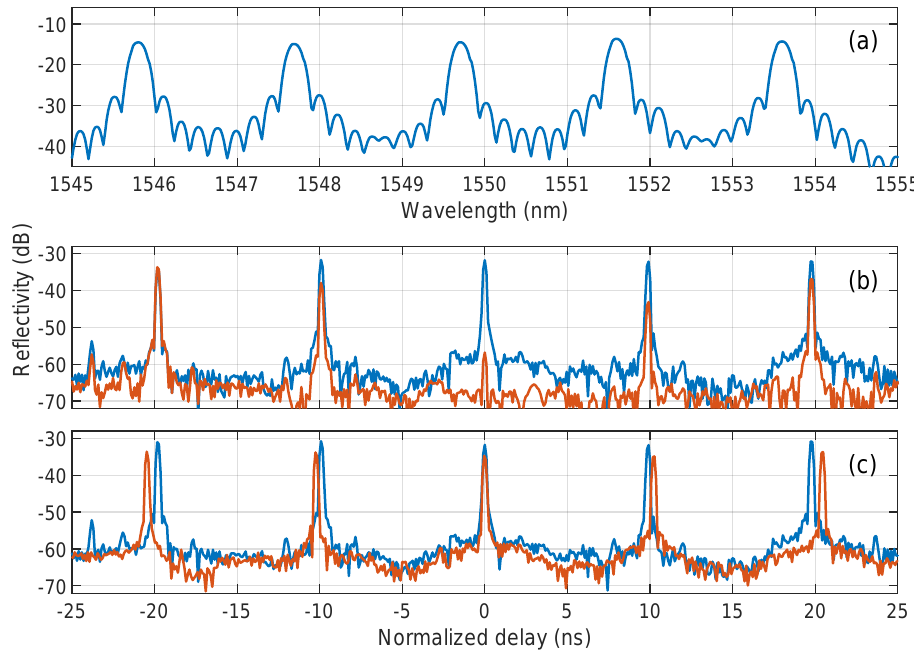
Figure 7. ( a ) FBG array measurement with orthogonally polarized light; ( b ) addition of traces on ( a )) with (orange) and without (blue) CFBG right before down-converting MZM; and ( c ) FBG array reflectivity spectrum with resolution bandwidth 0.5 nm (blue) and 0.06 nm